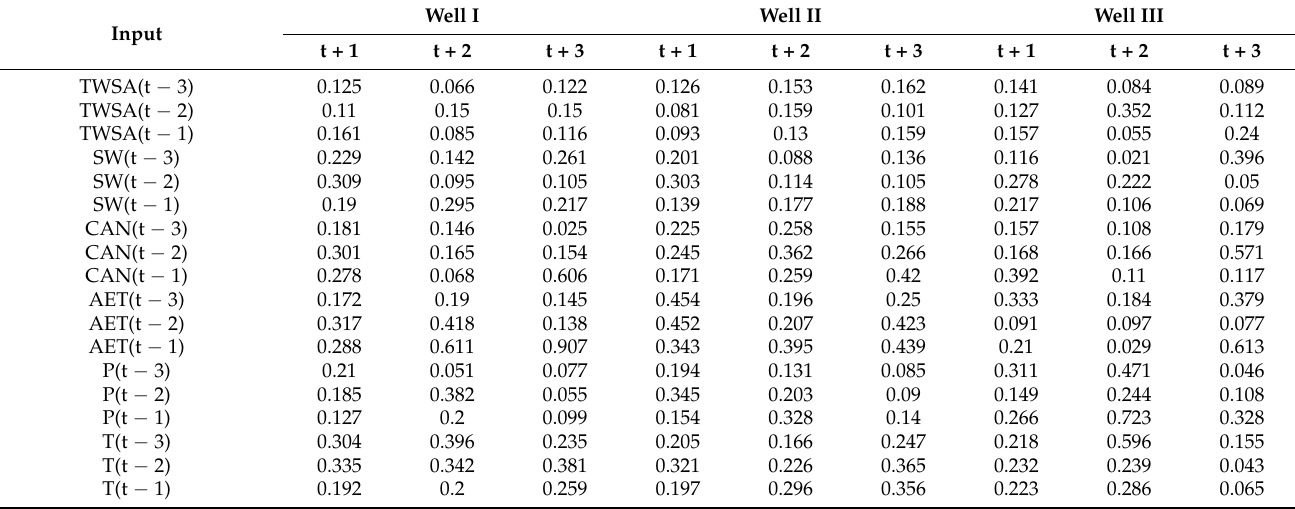
Table A3. Importance of the input variables based on calculating the residual sum of squares (unit: